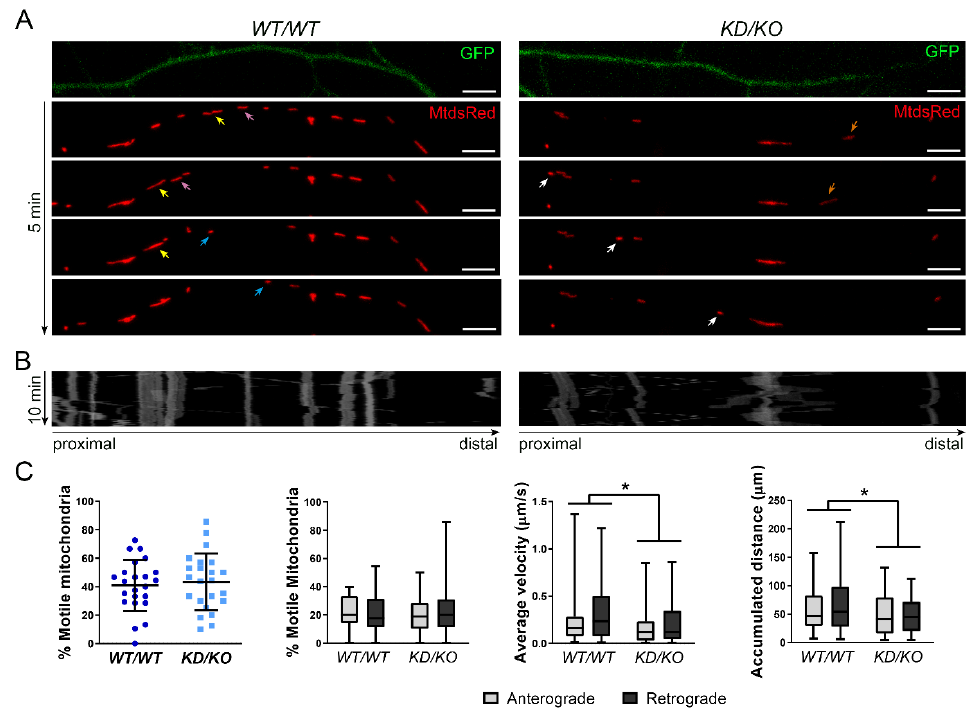
Figure 4. Mitochondrial trafficking is reduced in KD / KO hippocampal neuron axons . ( A ) Mito- chondrial trafficking live imaging from WT / WT and KD / KO hippocampal cells (representative images of different timepoints over 5 min). Neurons were transfected with GFP to visualize the axon and MitoDsRed to label mitochondria. Yellow, pink, and orange arrows indicate mitochondria moving in anterograde direction. Blue and white arrows point mitochondria moving in anterograde direction. Scale bars: 5 µ m. ( B ) Kymographs showing the path of each mitochondrion along the axons for 10 min. ( C ) CERKL depletion impairs mitochondrial trafficking in hippocampal axons. Per- centage of total motile, anterograde, and retrograde mitochondria is not different between genotypes. However, average velocity and accumulated distance are reduced in KD / KO axons of hippocampal neurons. Statistical analysis by t -test and two-way ANOVA. n = 50–57 mitochondria from n = 23 axons per genotype. *: p -value ≤